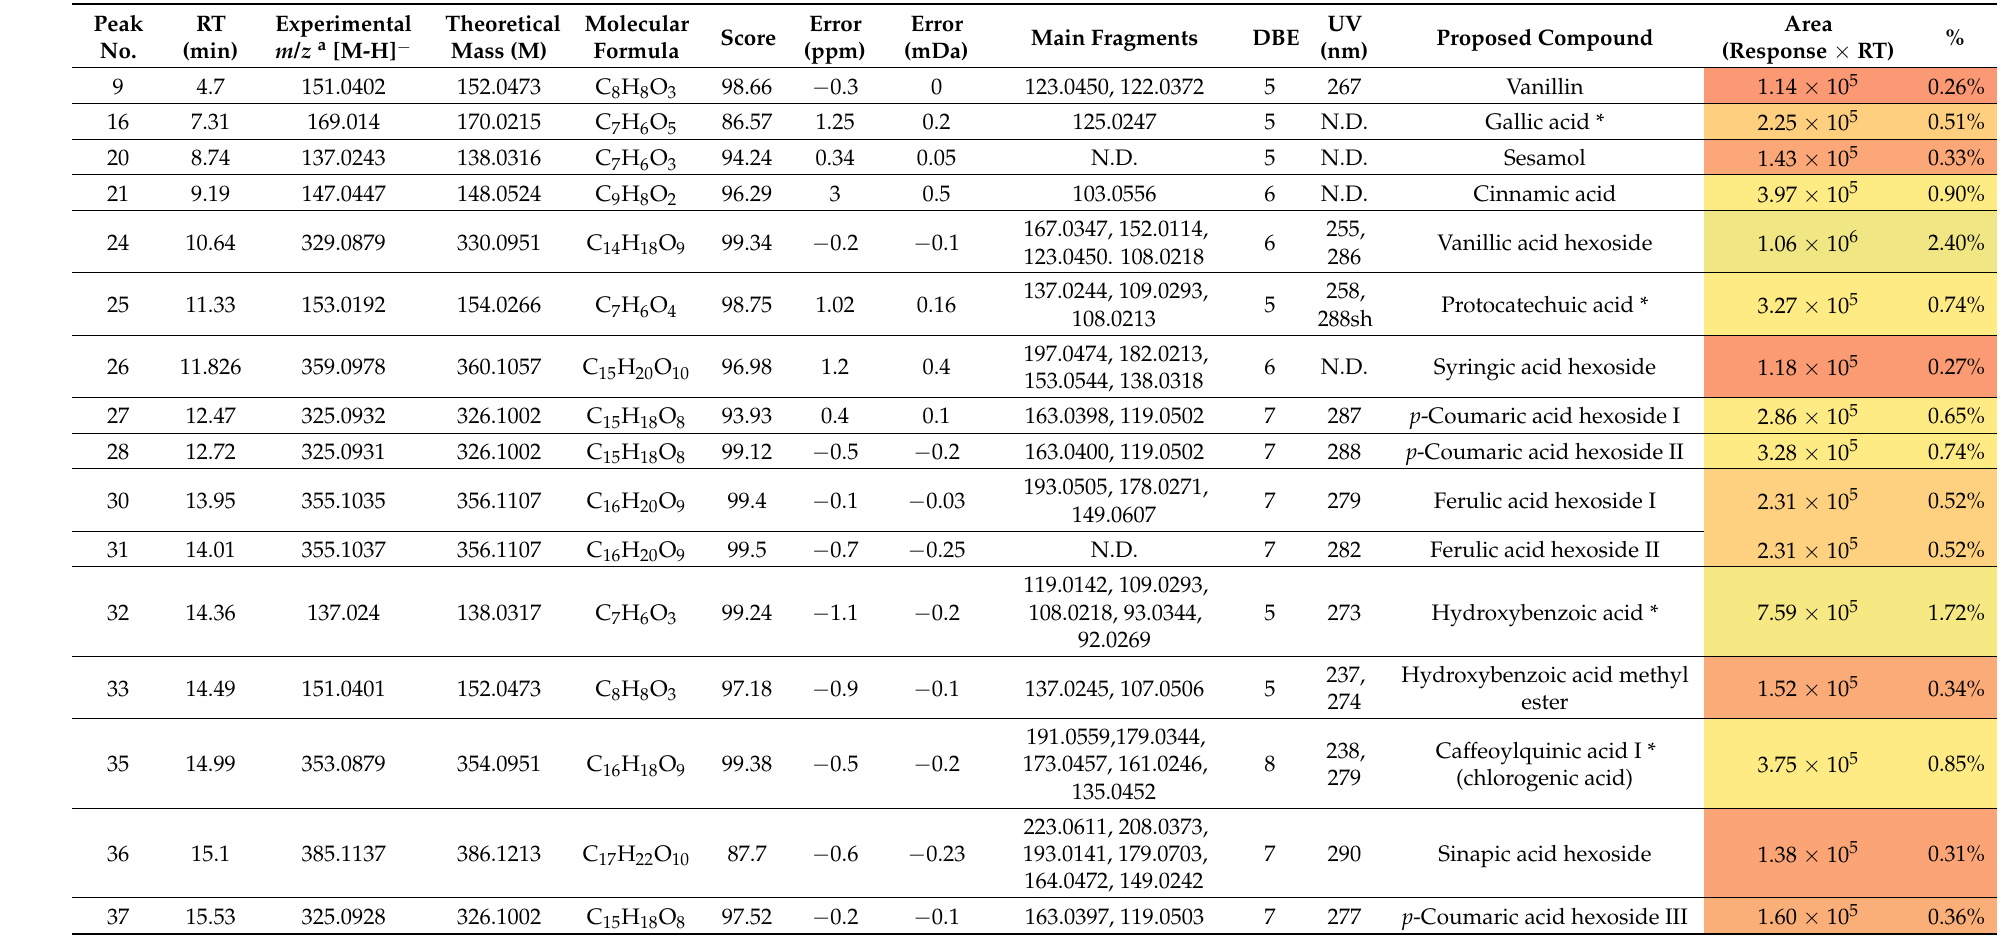
Table 1. Phenolic compounds characterized in SG32